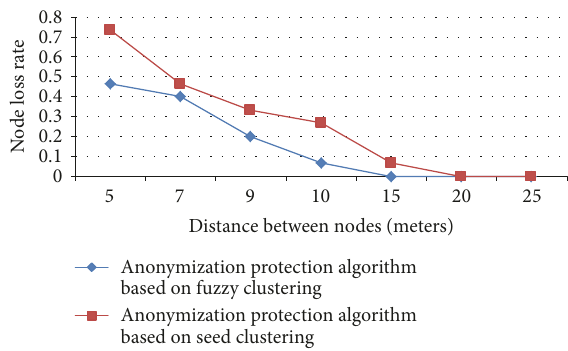
Figure 4: The two loss rates of node